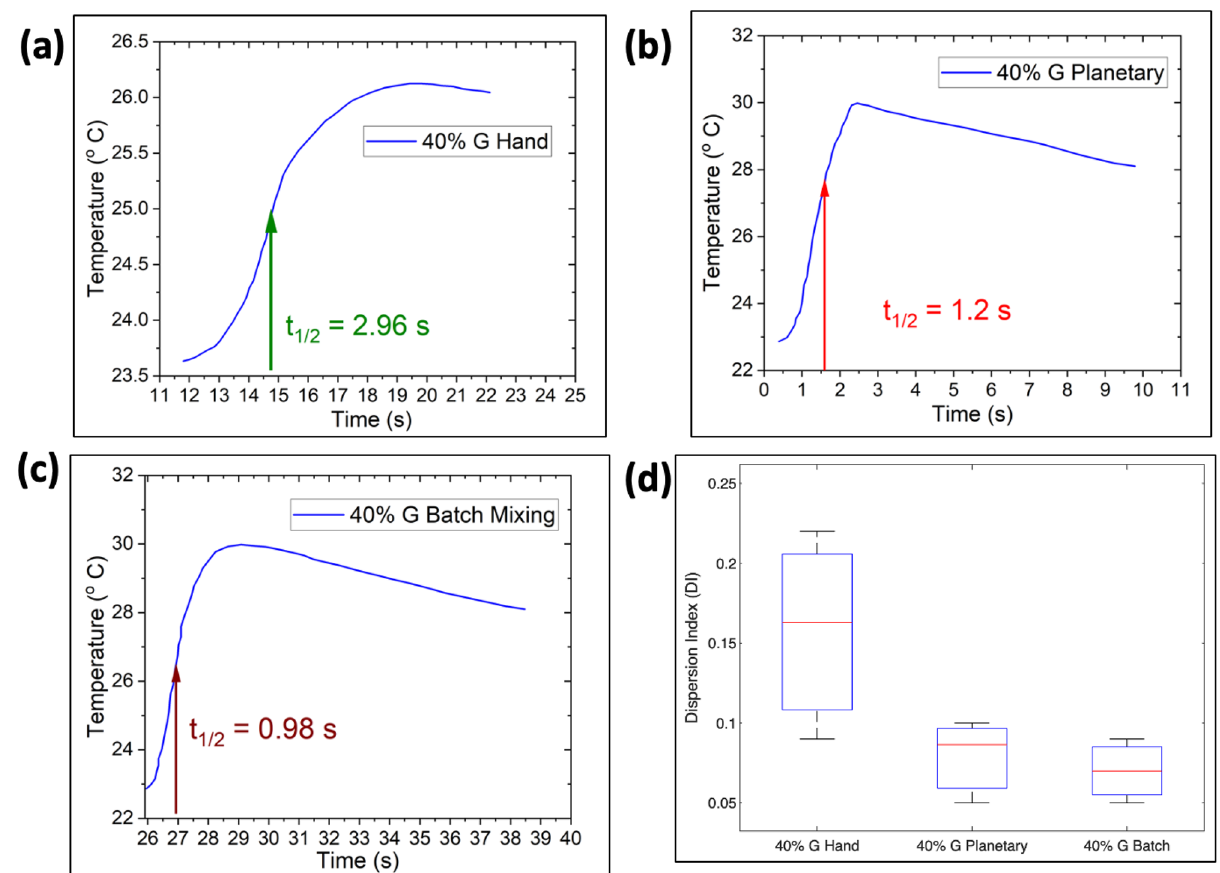
Figure 5. Thermal diffusivity of 40% G Ecoflex prepared by ( a ) hand mixing, ( b ) planetary mixing, ( c ) batch mixing, ( d ) dispersion index (DI) comparison of hand, planetary, and batch